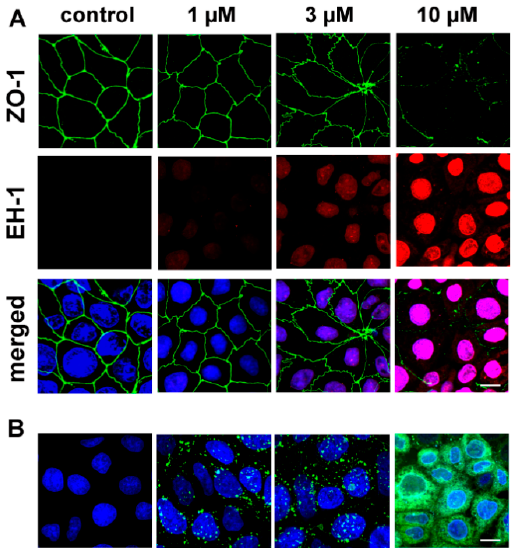
Figure 7. ( A ) Fluorescent staining of juntional protein zonula occludens-1 and double staining of cell nuclei in Caco-2 cells after 1-h treatment with PN159 peptide. Green color: immunostaining for ZO-1. Red color: staining by ethidium homodimer-1 (EH-1), indicating increased membrane permeability.Blue color: staining of all cell nuclei by H33342. Bar = 10 µ m. ( B ) Confocal microscopy images of living Caco-2 epithelial cells incubated with Bodipy FL labeled PN159 peptide in different concentrations for 5 min at 37 ◦ C. Green color: BodipyFL-PN159 peptide. Blue color: staining of cell nuclei. Bar = 10 μ m.